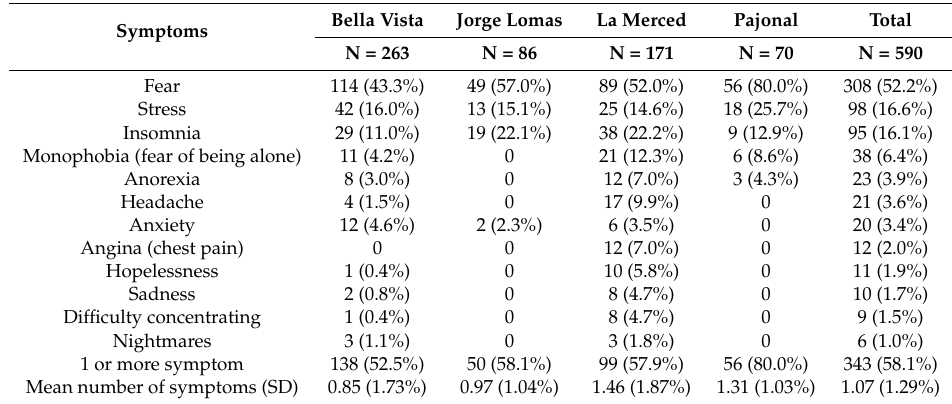
Table 3. Prevalence of psychological distress symptoms by study site. Respondents (n and %) who reported distress symptoms by site.